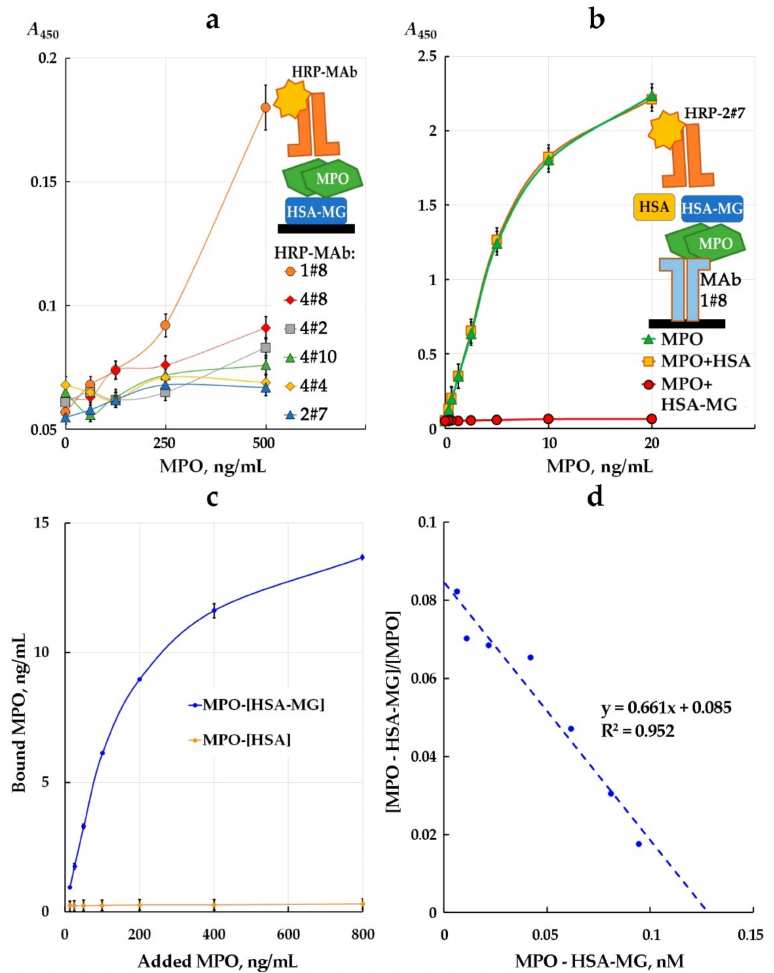
Figure 4. Illustration of competition between HSA-MG and mAbs against MPO for binding MPO in ELISA and determination of K d of complex MPO with HSA-MG. ( a ) Competition in case of HSA-MG immobilization on solid phase, detection of MPO by HRP-labeled mAbs with TMB-H 2 O 2 - staining ( A 450 ). ( b ) Competition in case of adding HSA-MG (or HSA—negative control) to MPO samples in “sandwich” ELISA: mAbs (1#8) immobilization on solid phase, detection of MPO by HRP-labeled mAbs (2#7) with TMB-H 2 O 2 -staining ( A 450 ). ( c ) Binding of MPO with HSA-MG or HSA in ELISA assay. ( d ) Scatchard plot illustrating dependence of [MPO-HSA-MG]/[MPO]: ratio of MPO in complex with HSA-MG to free MPO from concentration of complex MPO-HSA-MG. All measurements were performed in triplicate ( n =